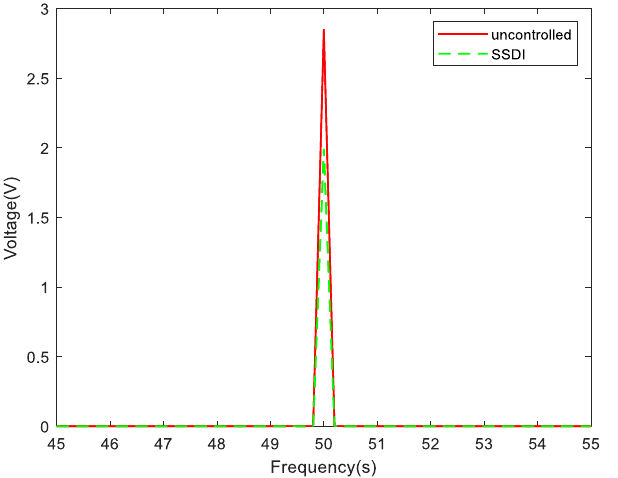
Figure 23. Displacement comparison curves in the frequency domain with and without an SSDI (50 Hz).